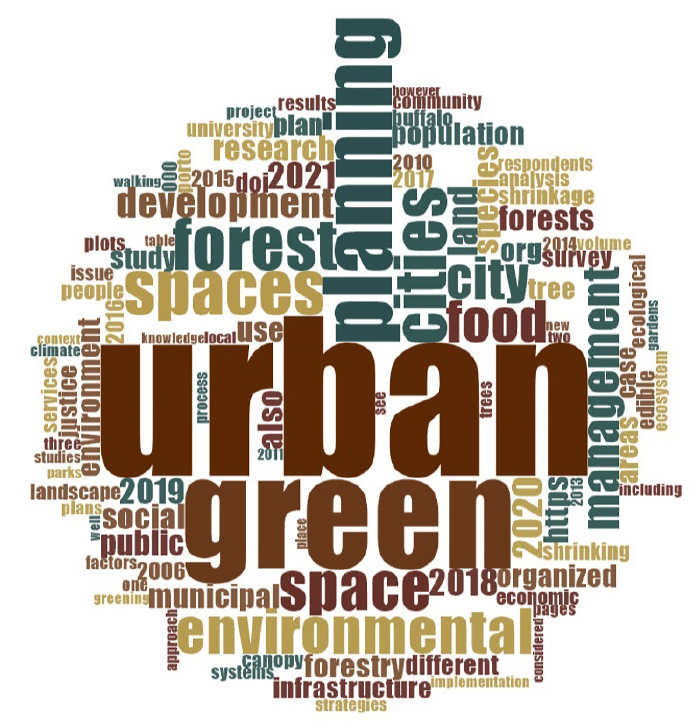
Figure 1. The 100 most frequently used words in this thematic issue, using NVivo 12